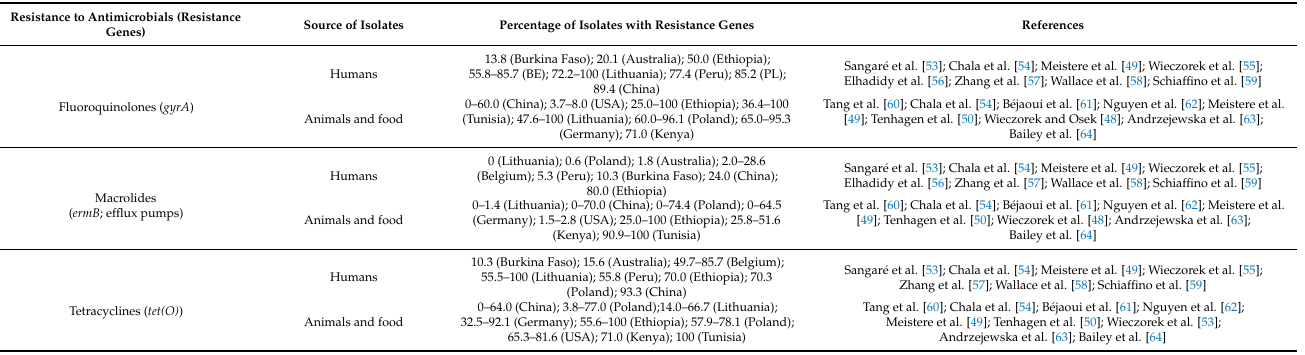
Table 1. Examples of prevalence of antimicrobial-resistant Campylobacter spp. isolated from various